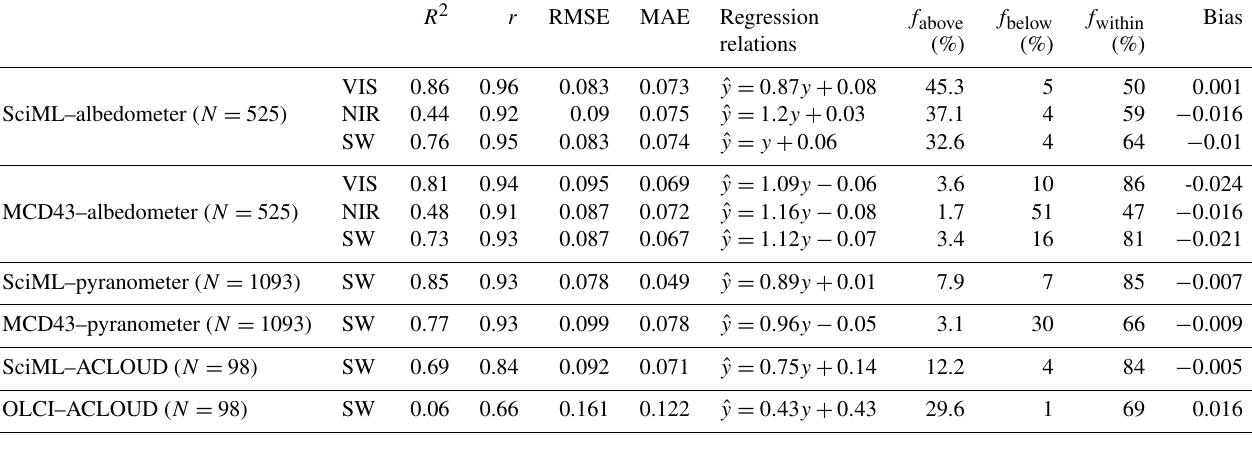
Table B3. Summary of the evaluation results for MCD43D and OLCI. The data were divided into four categories: three broadband albedos determined by the albedometer’s spectral range and a single broadband shortwave albedo determined by the pyranometer’s range. RTM– SciML retrievals have been regridded to compare the validation errors. R -squared values ( R 2 ), Pearson r coefficient ( r ), root-mean-square error (RMSE), mean absolute error (MAE), f above , f EE ≤ 15 , f below , and bias are used to evaluate the retrieval in the subcategories (snow, ice, and water) and the total valid data (“all”). On the left side of the table, the total number of data in each subgroup is included ( N ).